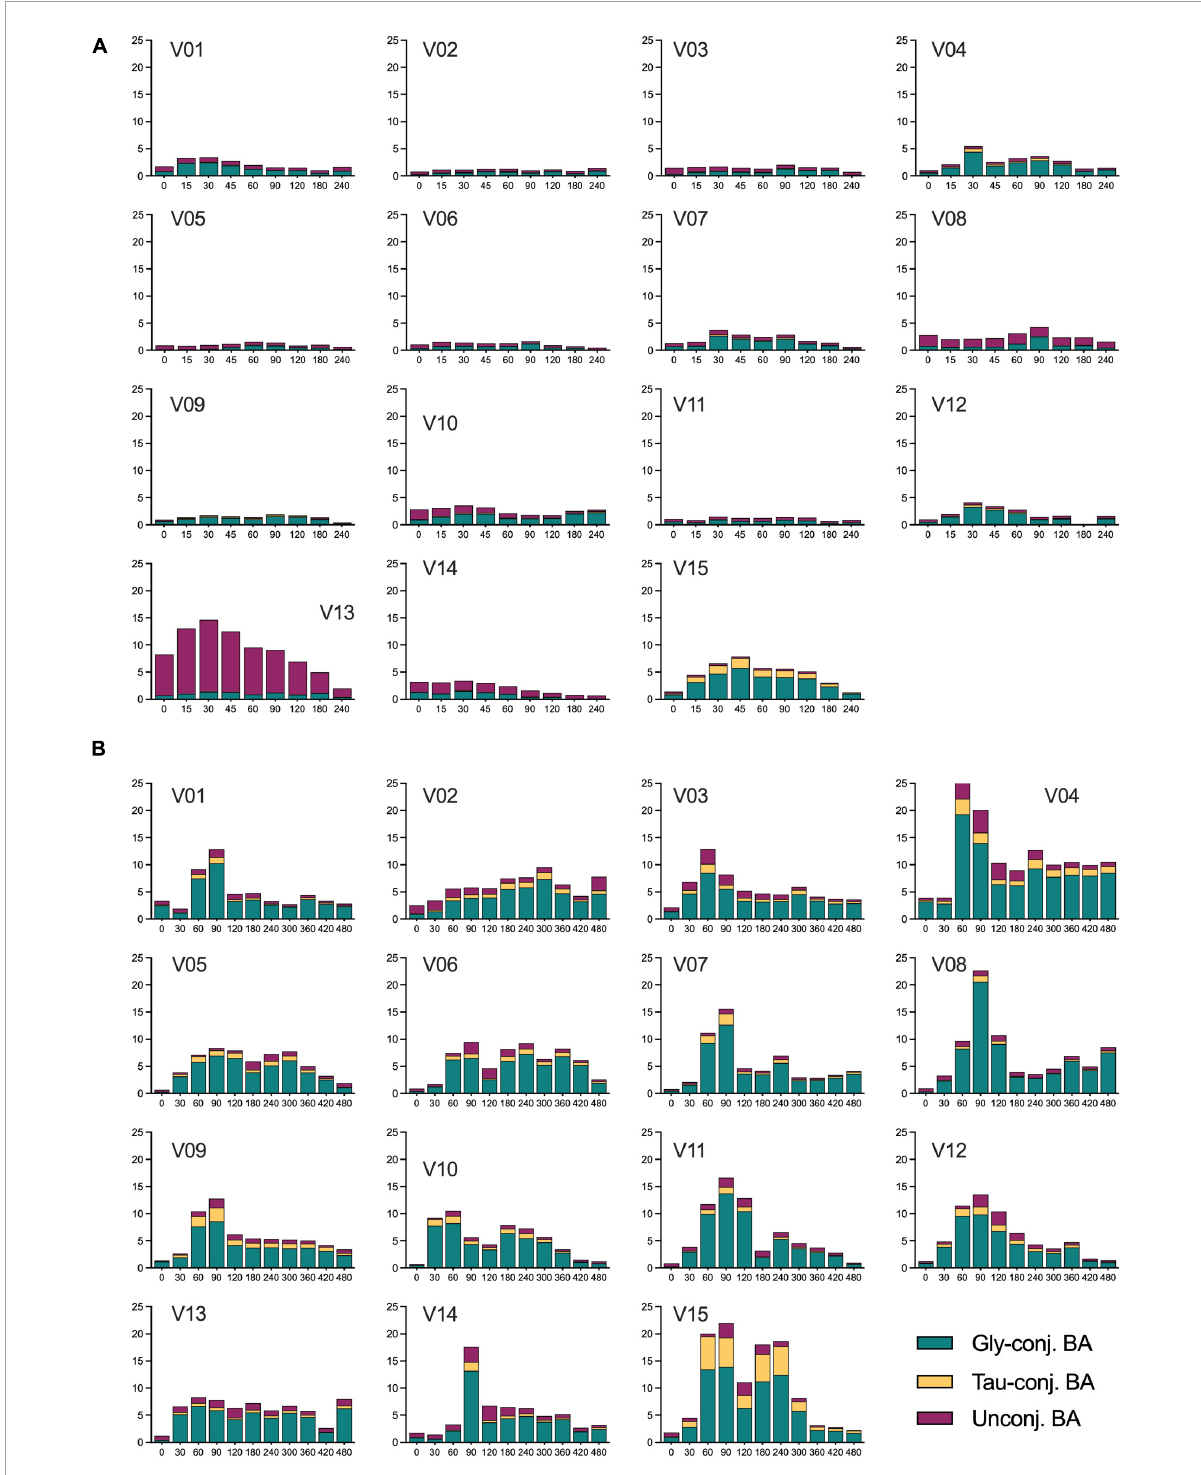
FIGURE4 Concentration of unconjugated, glycine- and taurine-conjugated BA in plasma samples of all subjects during the OGTT and OLTT. (A) Concentrations of the three classes of BA in each individual during the OGTT. (B) Concentrations of the three classes of BA in every subject during the OLTT. V01, V02 ... V15 refer to individual study subjects. The concentration of the BA classes is expressed as µ mol/L with the X -axis given in